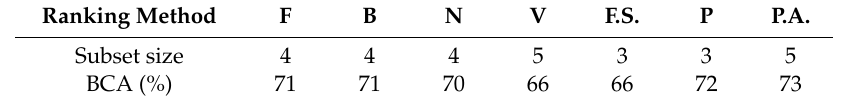
Table 7. Ranking methods performance comparison on the Melanoma dataset using Logistic regression.